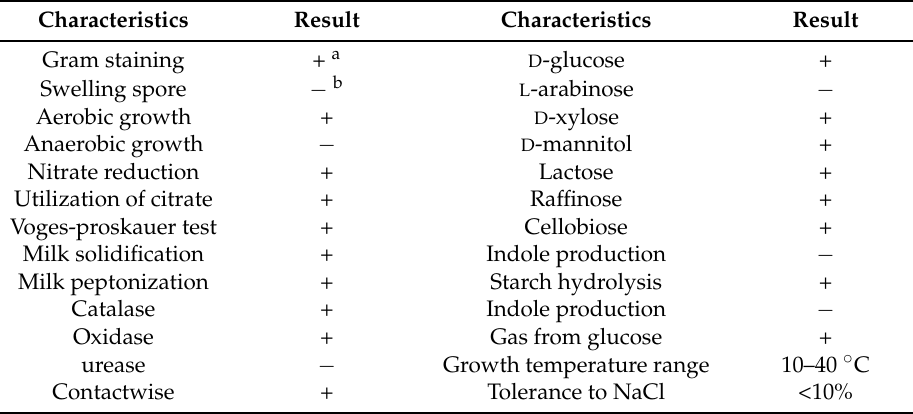
Table 1. Physiological and biochemical characteristics of strain SZ-1.